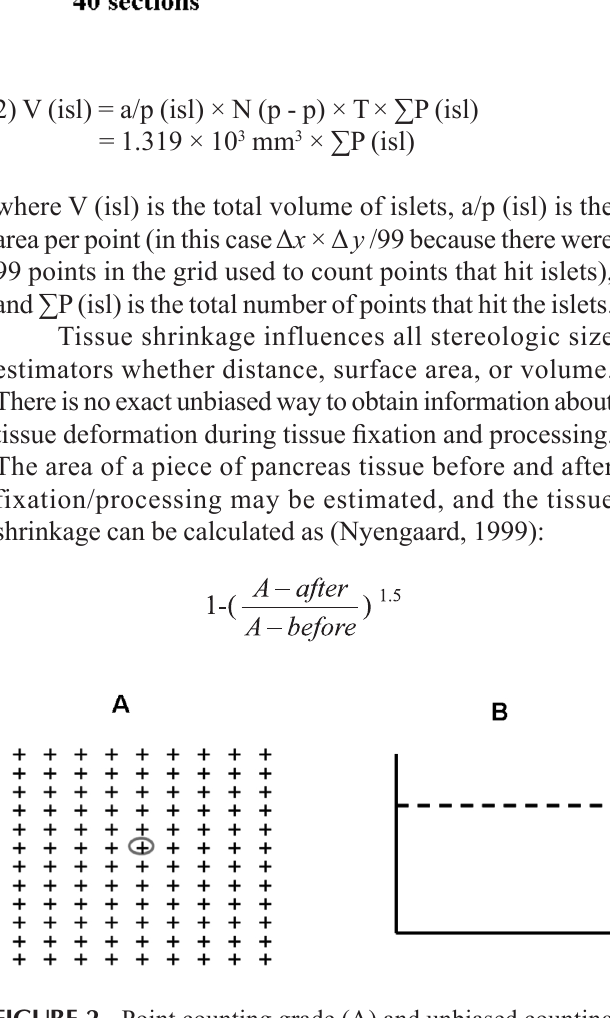
FIGURE 2 - Point counting grade (A) and unbiased counting frame